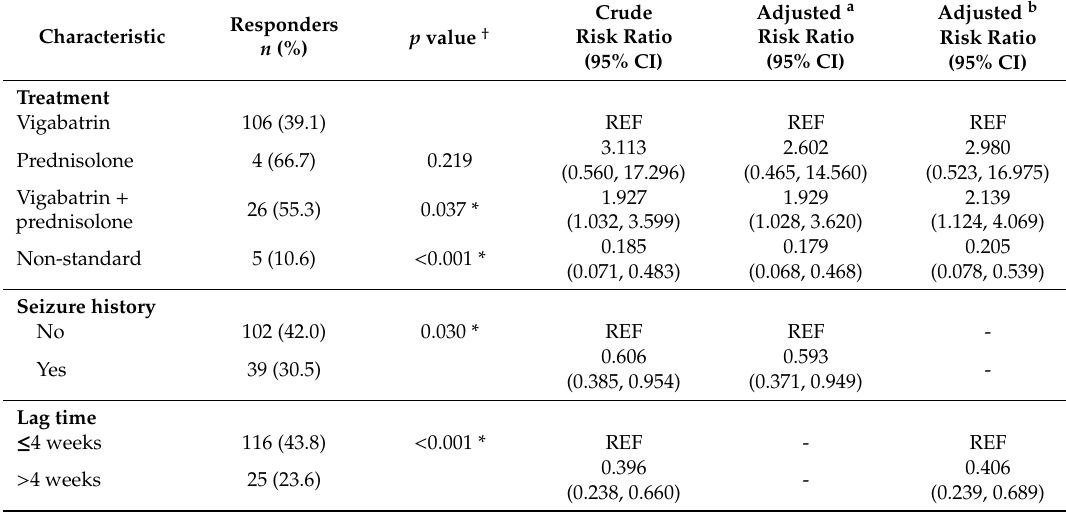
Table 3. Relative probability (relative risk) of response to